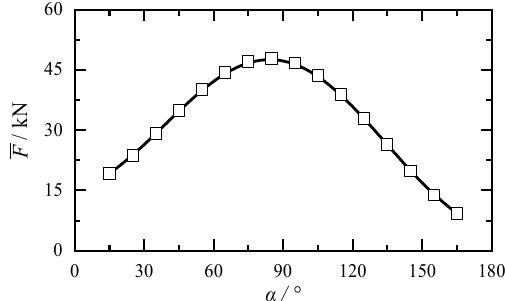
Figure 20. Mean side force at a variety of crosswind angles ( U = 20 m/s, V = 300 km/h).